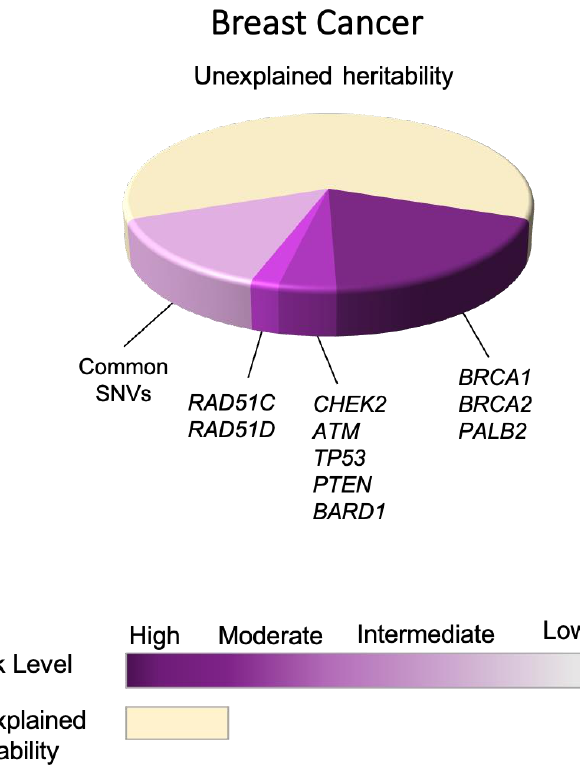
Figure 1. Illustration of the proportional contributions of breast cancer susceptibility risk genes (high- and moderate-penetrance genes), and common risk alleles to breast cancer.